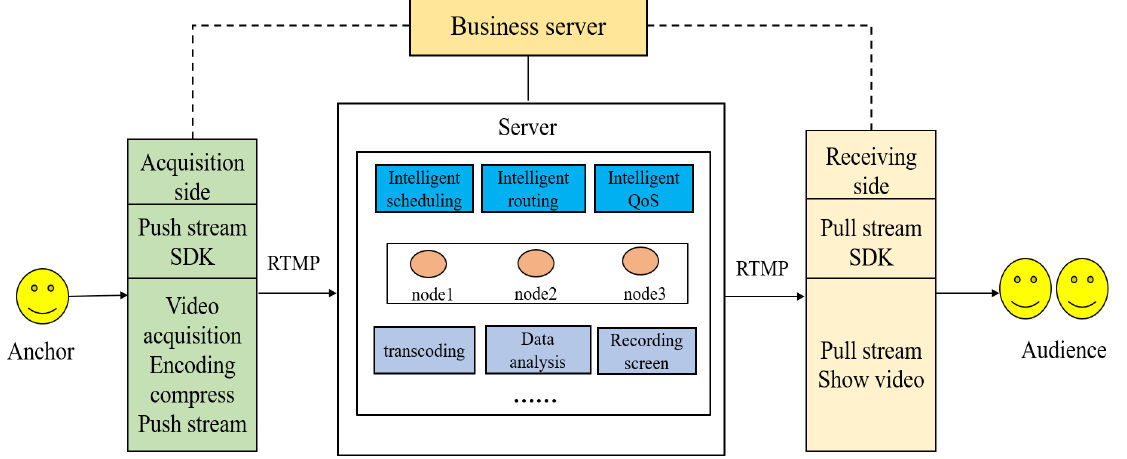
Figure 10. Live video